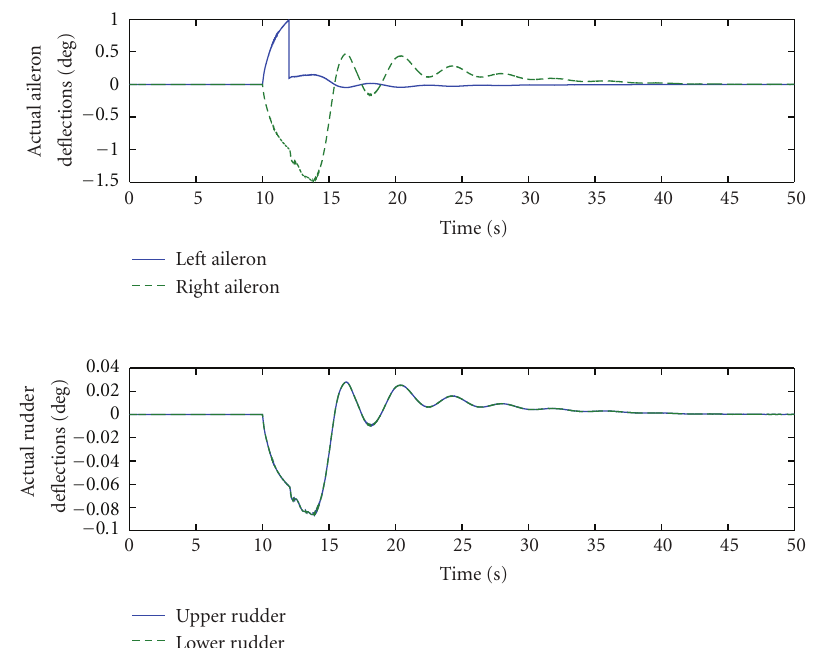
Figure 13: Time history of actuator deflections.